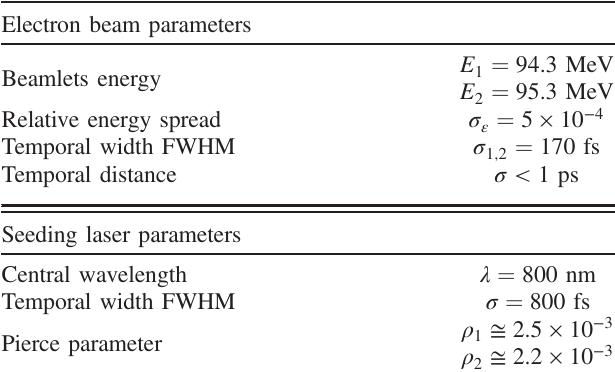
TABLE II. List of parameters for the electron beam and the seeding laser as used in the experimental configuration at the seeded SPARC